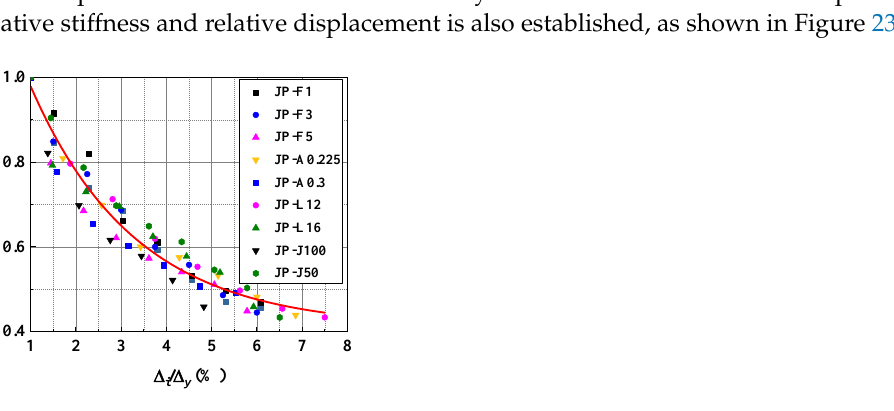
Figure 23. Relationship between relative displacement and relative stiffness after yield.